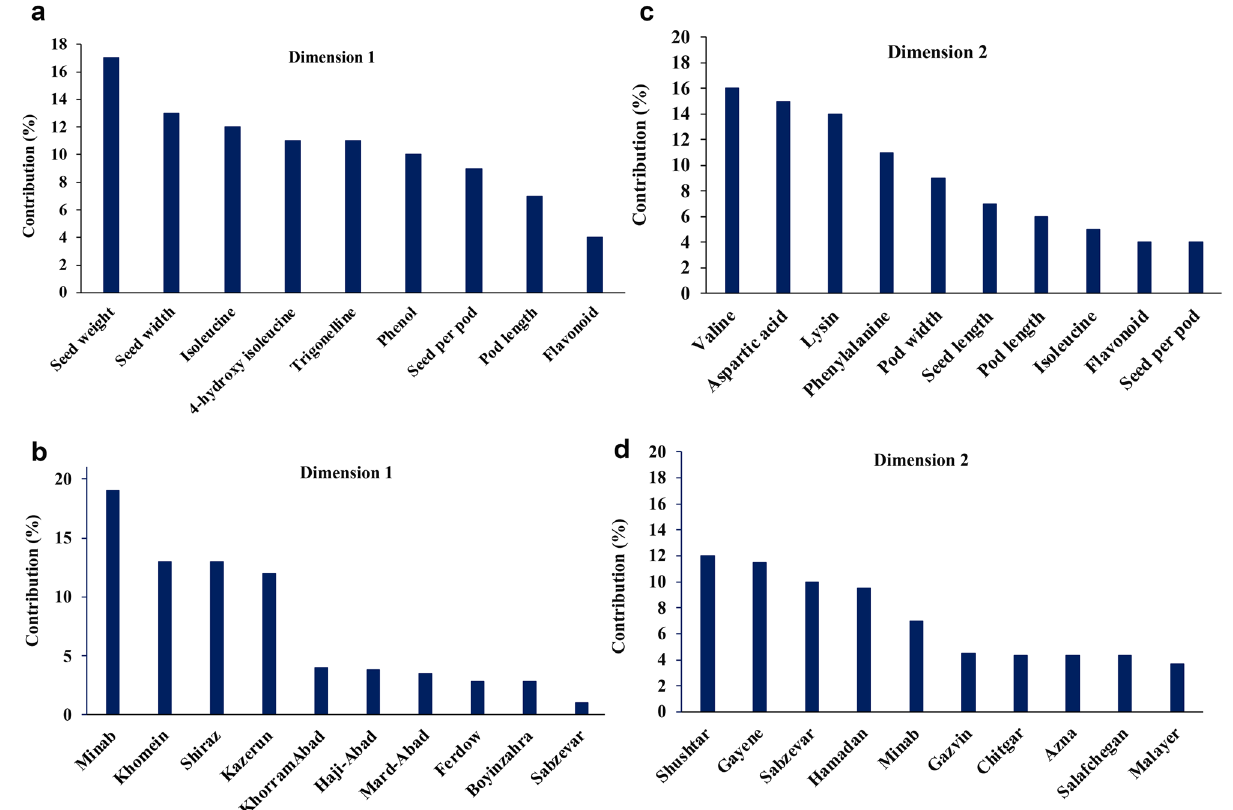
Figure 1. The Bar graph of percentages of contribution yield related triats and metabolite variables a: Minab with 19% and Sabzevar with 0.5% were the highest and lowest contribution variables to dimensions 1 ( a and b ), respectively. In dimensions 2 ( c and d ), Shushtar with 12% and Malayer with 3% were the highest and the lowest contribution variables, respectively.: seed weight (17%) and flavonoids (4%) showed the highest and the lowest percentage of contribution in dimensions 1 ( a ), respectively. In dimension 2 ( b ), valine (16%) and seed per pod (4%) had the highest and lowest percentages of contribution, respectively.